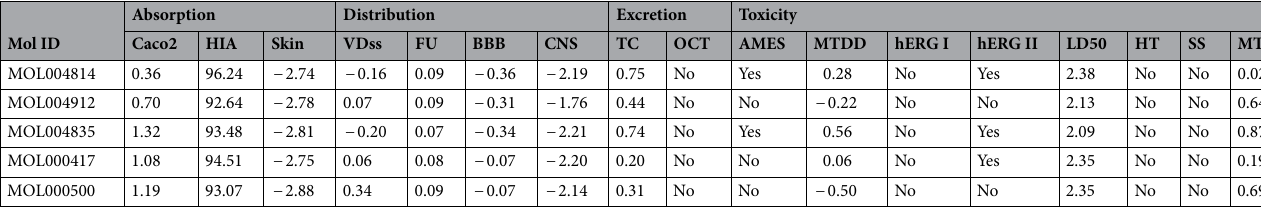
Table 7. Non-toxic